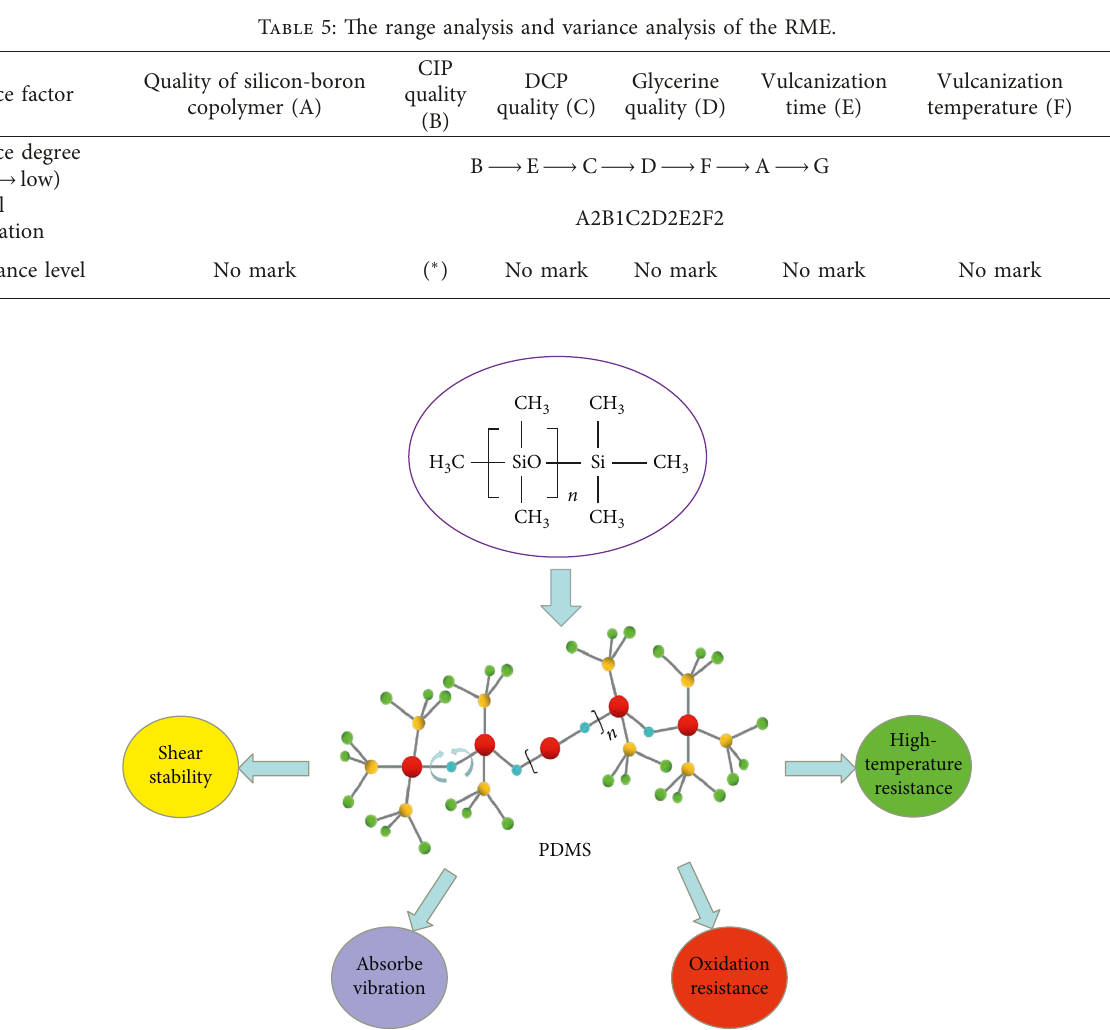
Figure 4: The performance advantages and molecular structure of